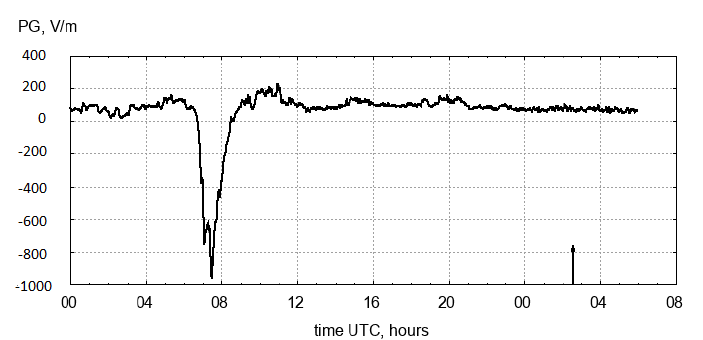
Figure 10. Negative anomaly in the electric field before the earthquake (arrow) on 27 July 2022, Ms =